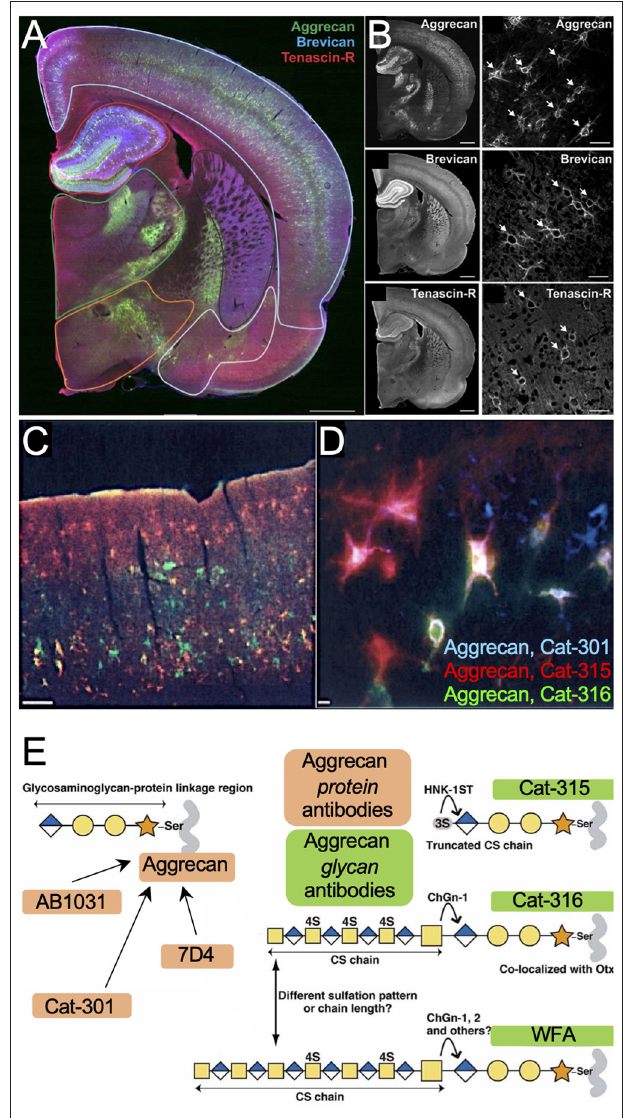
FIGURE 8 | Distribution of PNN subpopulations throughout rat brain. (A) Rat brain stained for PNN CSPGs aggrecan ( green ) and brevican ( blue ), and PNN cross-linker Tenascin-R ( red ), shows region-specific differences in (B) PNN subpopulations throughout the brain. Scale: 1mm and 50 µ m (See Dauth et al., 2016). (C,D) Rat brain labeled for aggrecan + PNNs using antibodies Cat-301 ( blue ), Cat-315 ( red ), and Cat-316 ( green ) recognize different subsets of aggrecan + PNNs in the (C) cortex and (D) hippocampus. Scale: (C) 200 µ m, (D) 20 µ m (see Matthews et al., 2002) Copyright (2002) Society for Neuroscience. (E) Variability in aggrecan + PNN labeling may stem from distinctive antibody targets; whereas antibodies AB1031, Cat-301 and 7D4 recognize the aggrecan core protein, antibodies Cat-315, Cat-316 and WFA recognize the attached CS-GAGs and oligosaccharides (see Miyata et al., 2018). WFA, Wisteria floribunda